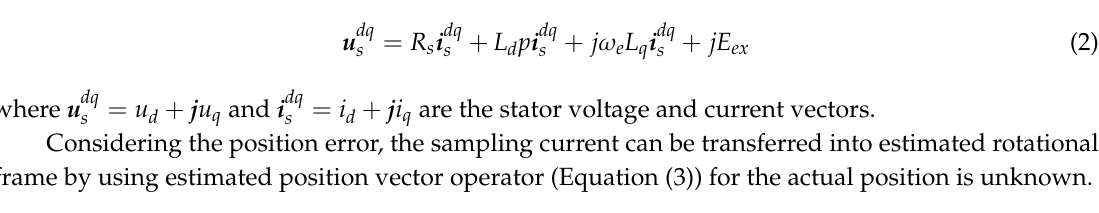
the d - and q -axis inductances, respectively.